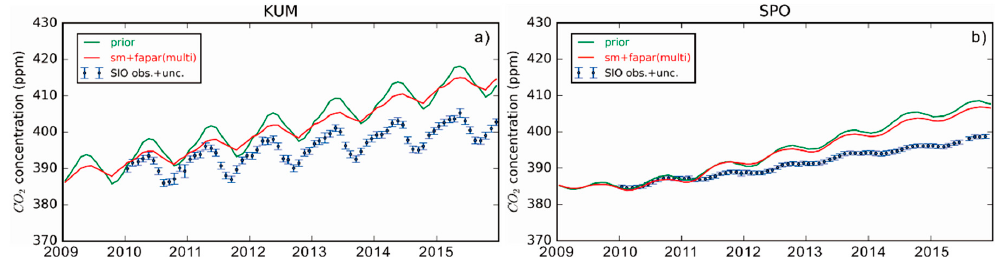
Figure S3. Comparison of observed CO 2 concentrations from two sites from the Scripps Institution of Oceanography network with simulations from different experiments, ( a ) for site KUM; ( b ) for site SPO. ‘Prior’ represents simulations with prior parameter values, ‘sm+fapar (multi)’ represents simulations with optimized parameter values from multi-site assimilation using SMOS soil moisture and FAPAR.